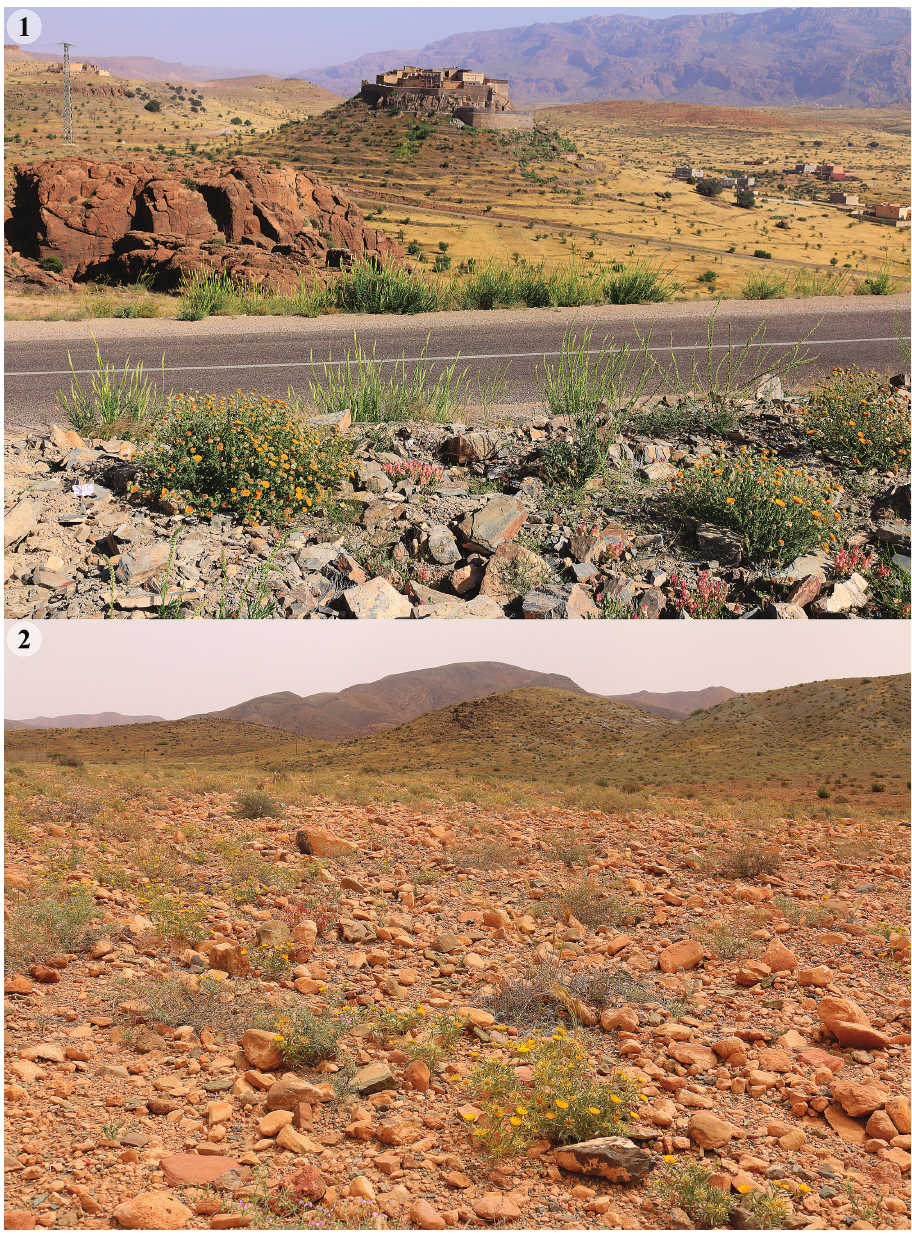
yellow flowering plants of Asteriscus graveolens that were visited by females of Q. major